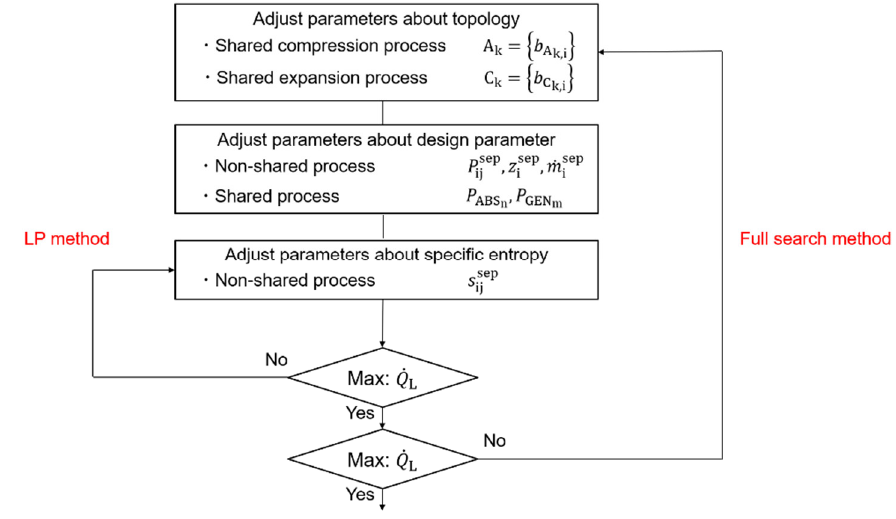
Figure 8. Optimization calculation procedure.